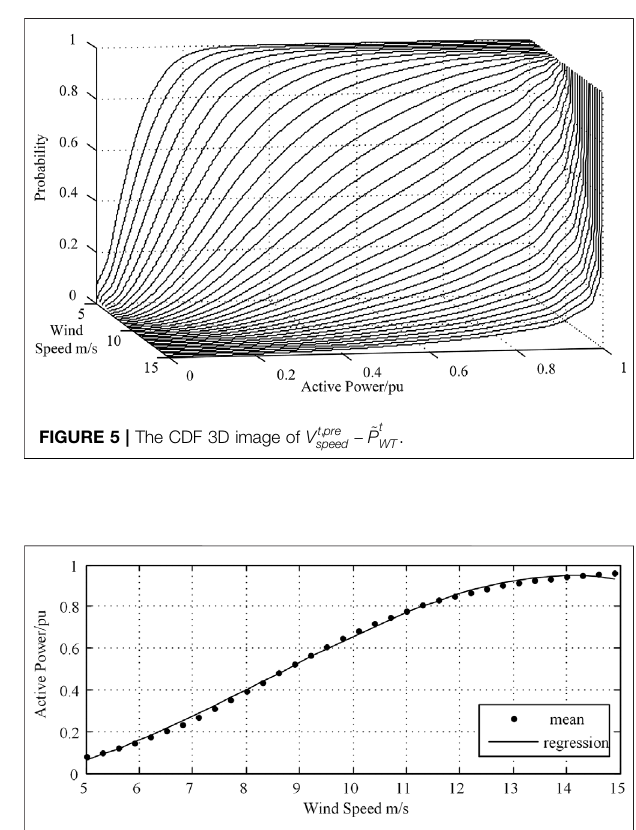
FIGURE 6 | Relation between reference value and mean value of controllable PV